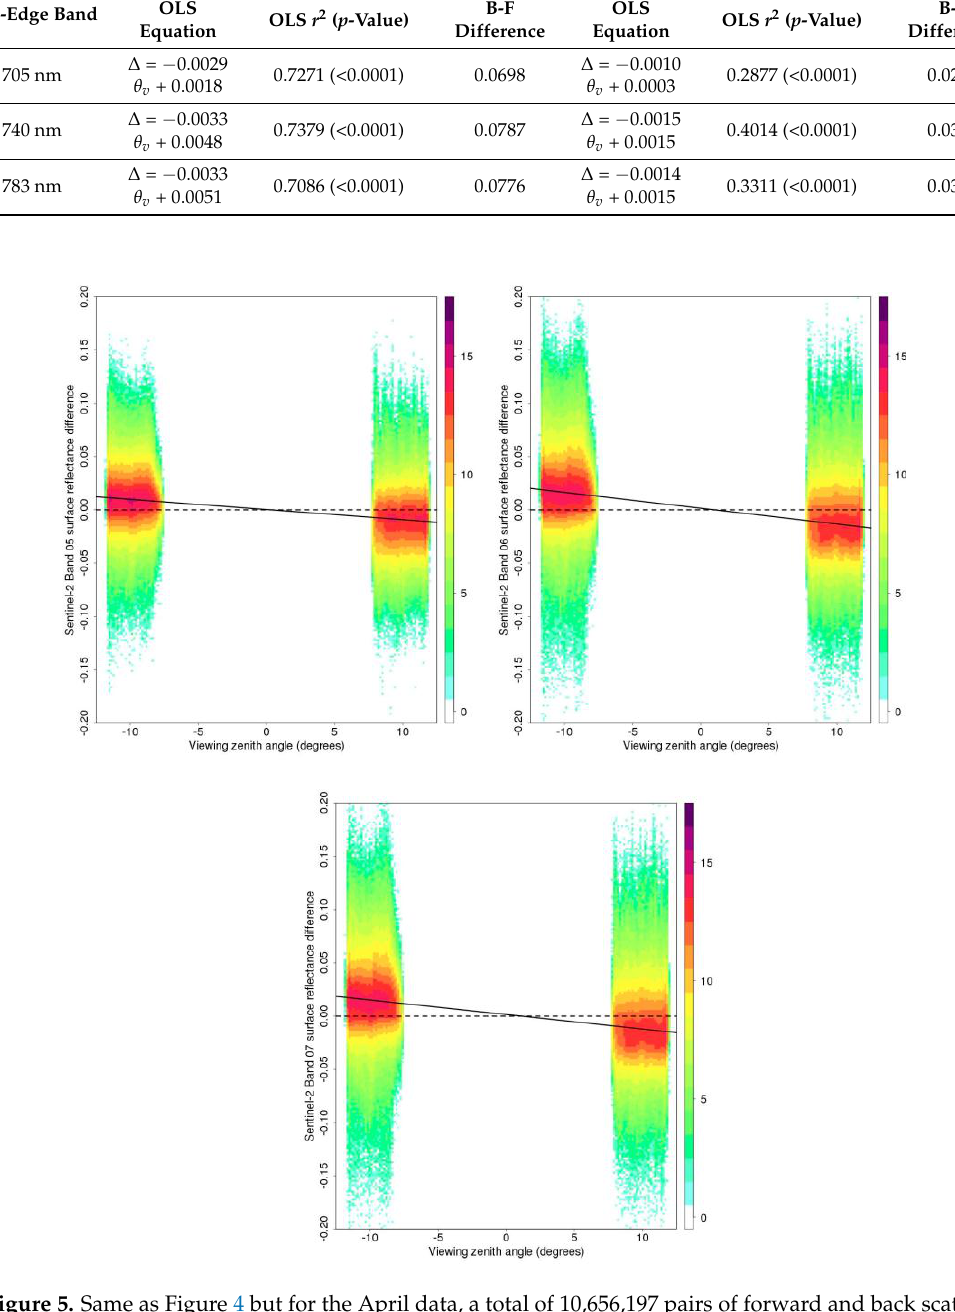
Figure 5. Same as Figure 4 but for the April data, a total of 10,656,197 pairs of forward and back scatter surface reflectance values were considered. The solid lines show ordinary least squares (OLS) linear regression fits of these data (see Table 4).